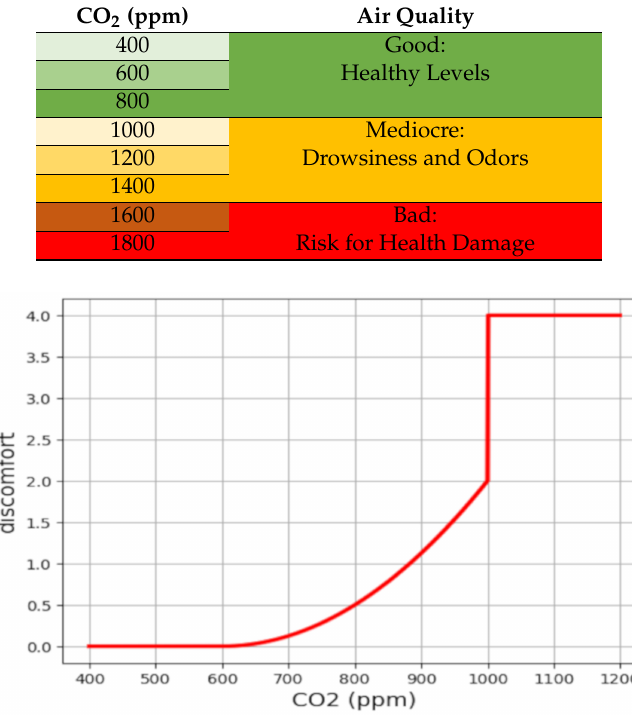
Figure 7. Hygienic discomfort.